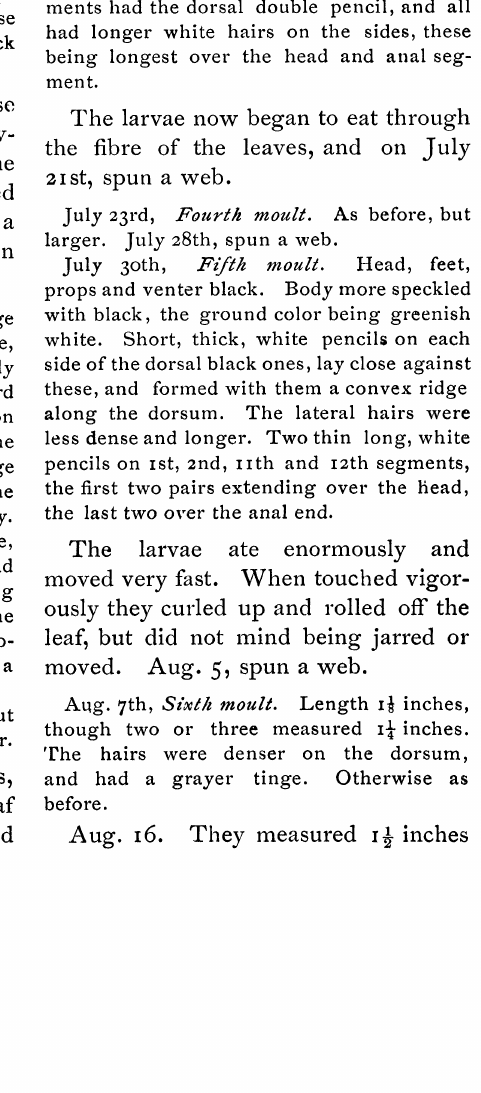
Third moult. Head round, slightly bilobed at top, shining black. Body as before except the hairs. st, znd and 3rd segments as before. 4th and oth segments had a longer pencil of black hairs arising from the black wart nearest the dorsal line, on each side, the hairs meeting over the line so as to give the effect of a single pencil. On each side, lower down, was a longer, single pencil, also black. The other seg- ments had the dorsal double pencil, and all had longer white hairs on the sides, these being longest over the head and anal seg- ment.